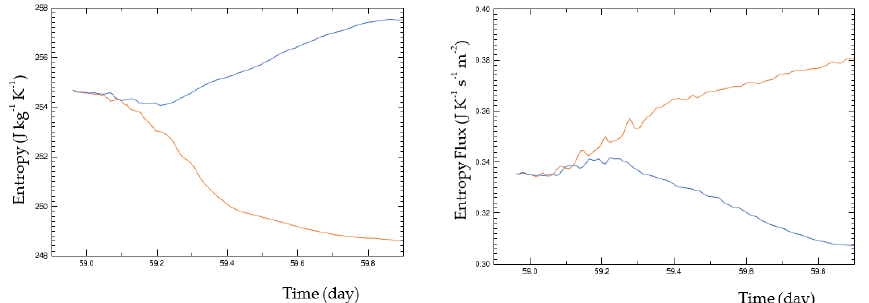
Figure 12. Modeled time series of ( left ) the surface moist entropy and ( right ) the entropy flux from the sea to the air in the (red) test and (blue line) reference columns.